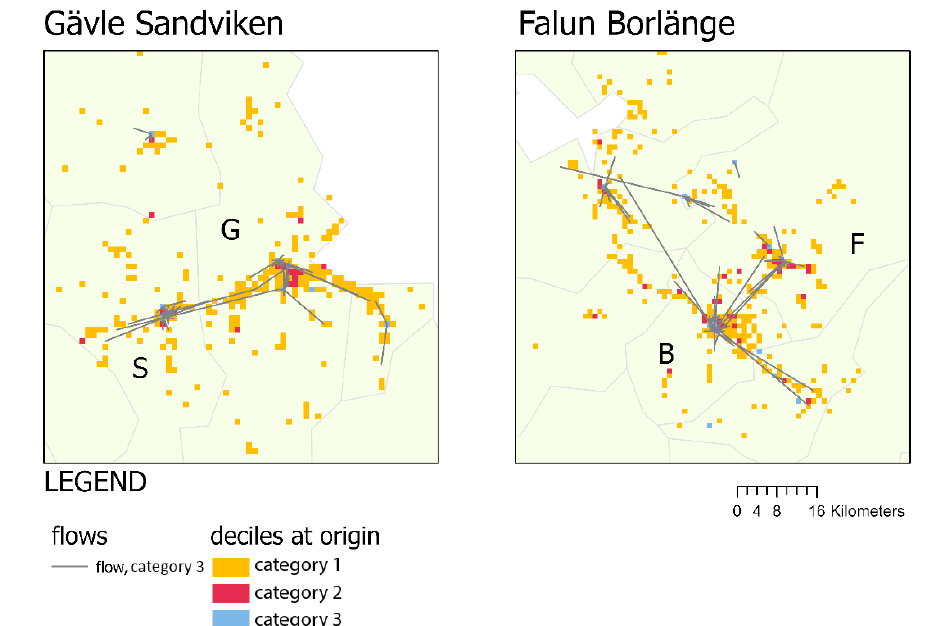
Figure 6. Flows starting in category 3. Note: Data from 28 March 2019, Thursday. composition of its origin. Hence, a phone starting in a km 2 unit with 50% non-Europeans is regarded as being 0.5 non-European. The categorization uses the same 70/20/10 distribution as the categorization based on the registry data.